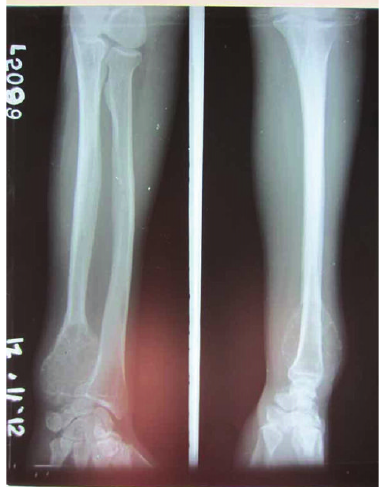
Figure 3: Preoperative X-ray.